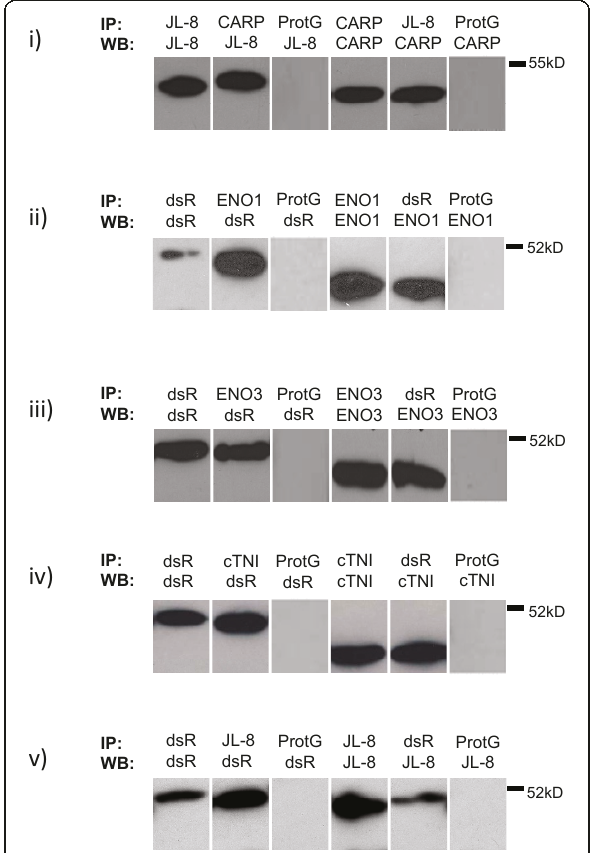
Figure 6 In vivo co-immunoprecipitation of MMGL and its respective preys identified in the Y2H library screen . Western blots supporting the co-localization data in Figures 4 and 5. Antibodies used in immunoprecipitation (IP) and Western Blot (WB) are shown above each lane. Endogenous CARP (i), ENO1 (ii), ENO3 (iii) and cTNI (iv) immunoprecipitated exogenous dsRed-/YFP-MMGL in vivo in lysates of ds-Red-/YFP-MMGL transfected, differentiated H9C2 cardiomyocytes, while GFP-COMMD4 immunoprecipitated dsRed- MMGL in differentiated H9C2 cardiomyocytes transfected with both GFP-COMMD4 and dsRed-MMGL. Conversely, dsRed- or YFP-MMGL immunoprecipitated endogenous CARP (i), ENO1 (ii), ENO3 (iii) and cTNI (iv) in lysates of ds-Red- or YFP-MMGL transfected, differentiated H9C2 cardiomyocytes, while dsRed-MMGL also